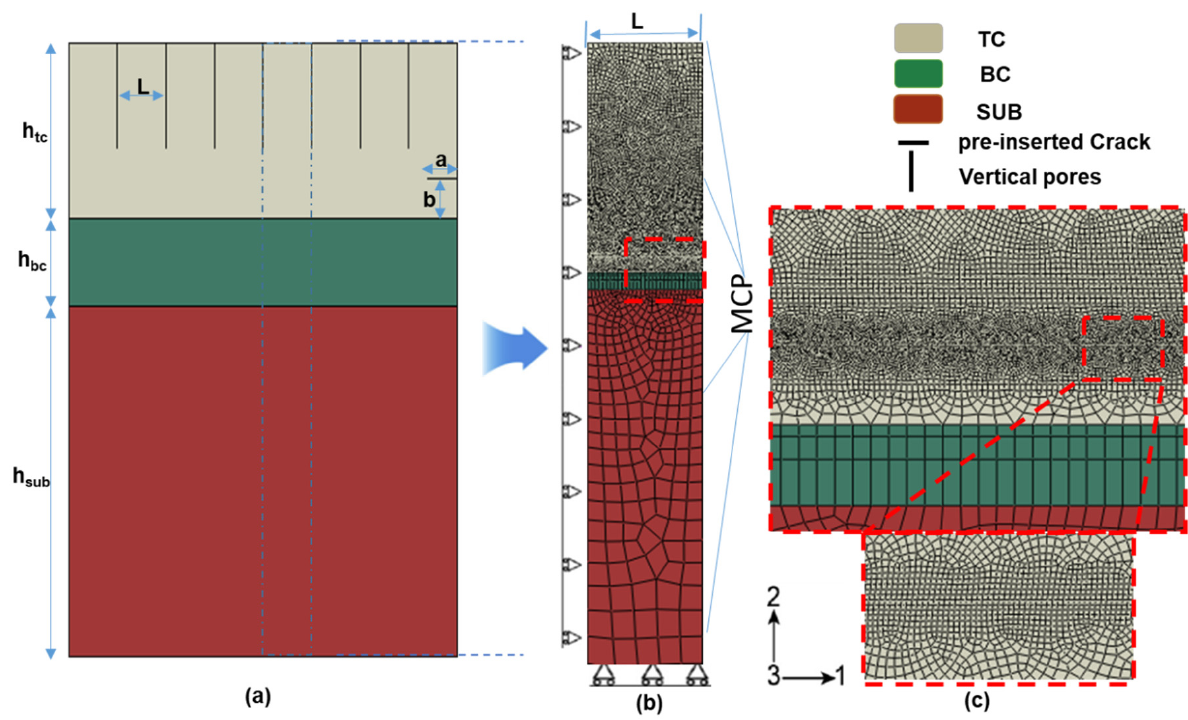
Figure 1. Model of TBCs with vertical cracks in TC: ( a ) the model geometry, ( b ) overall model mesh and boundary conditions, and ( c ) the dense mesh close to the TC/BC interface .